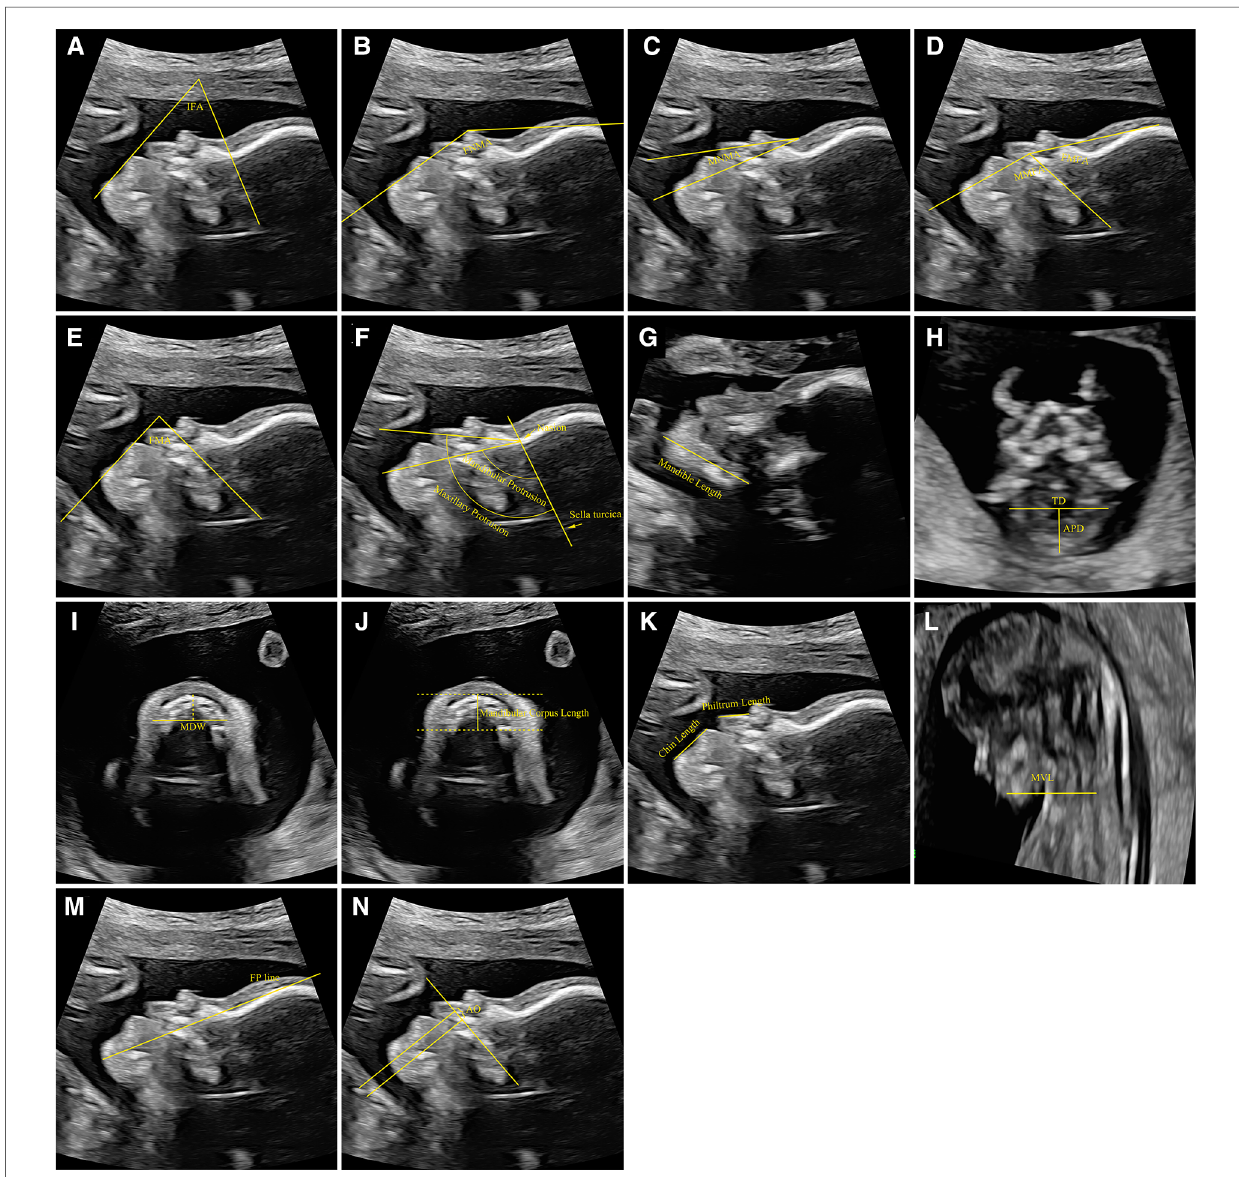
FIGURE 2 Measurement reference of biometric parameters related to the mandible. ( A ) The measurement of IFA, ( B ) the measurement of FNMA, ( C ) the measurement of MNMA, ( D ) the measurement of MMFA and FMFA, ( E ) the measurement of FMA, ( F ) the measurement of mandibular protrusion and maxillary protrusion, ( G ) the measurement of mandible length, ( H ) the measurement of APD and TD, ( I ) the measurement of MDW, ( J ) the measurement of mandibular corpus length, ( K ) the measurement of chin length and philtrum length, ( L ) the measurement of MVL, ( M ) the measurement of FP line, ( N ) the measurement of AO. IFA, inferior facial angle; FNMA, fronto-naso-mental angle; MNMA, maxilla-nasion-mandible angle; MMFA, mandibulomaxillary facia angle; FMFA, frontomaxillary facial angle; FMA, facial maxillary angle; APD, anteroposterior diameter; TD, transverse diameter; MDW, mandible width; MXW, maxilla width; MVL, mandibular vertebral length; FP, fetal pro fi le; AO, alveolar